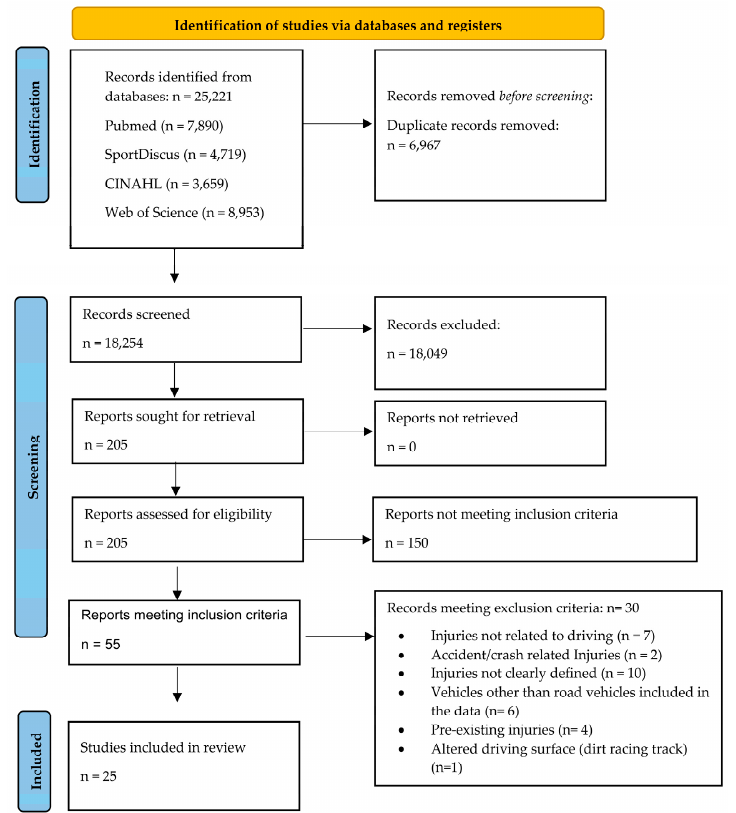
Figure 1. PRISMA flow diagram detailing the identification, screening, and final inclusion of studies.